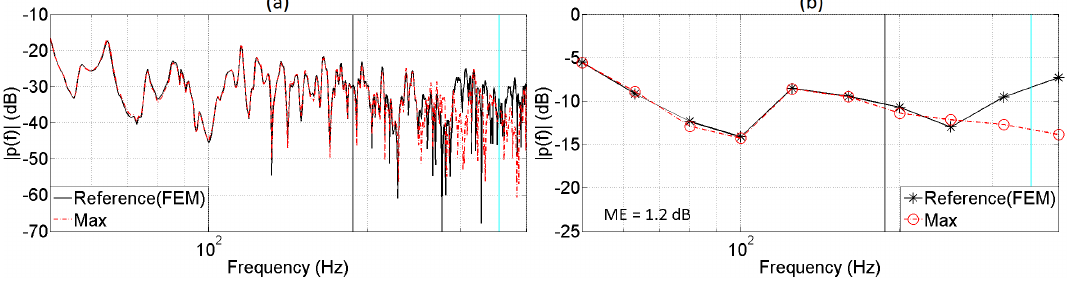
Figure 29. Comparison of full ( a ) and 1/3 octave band ( b ) frequency responses. Translated PWE ( W ) and reference ( W ) at translated Position 5.